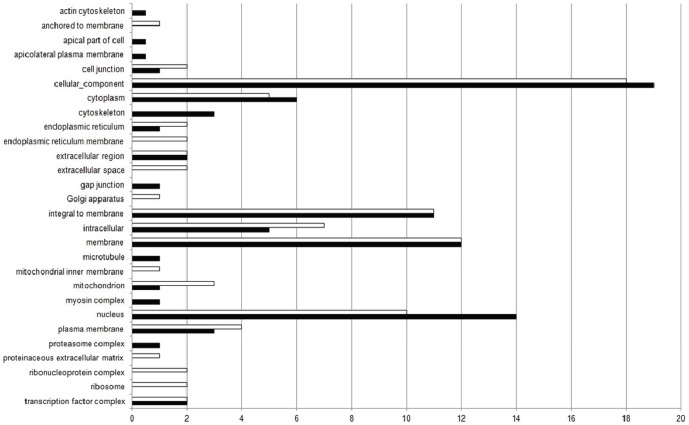
Comparison of Top20 GO terms found in the Cellular Component category.Percentage of Top20 terms related to the down-regulated (black bars) and up-regulated genes (white bars), selected in the Cellular Component category.